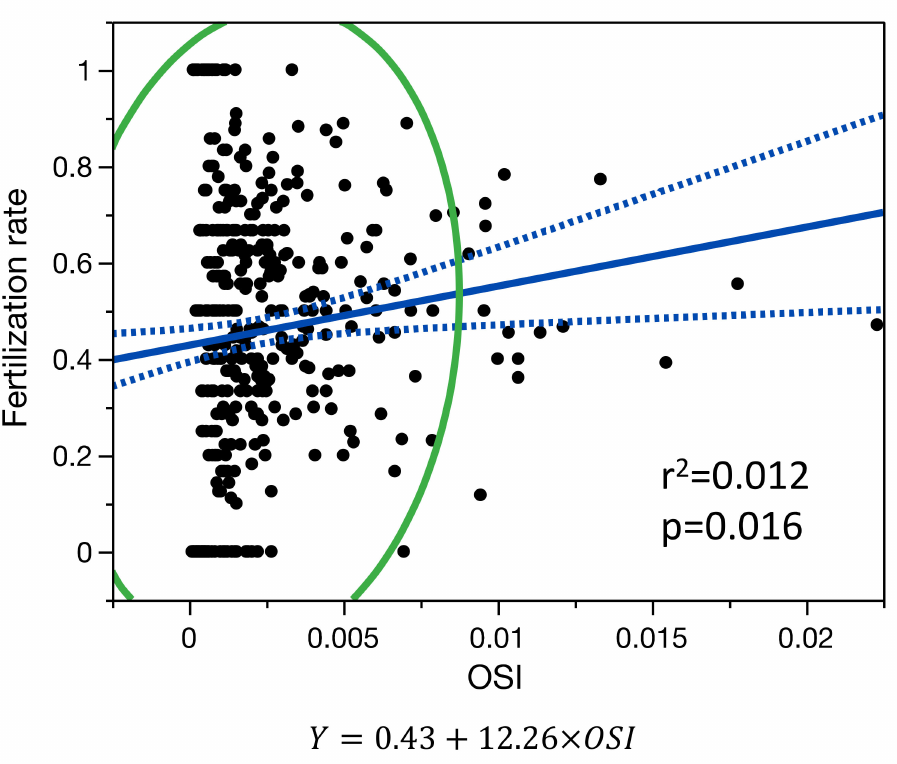
Figure 4. Single-variable linear regression model for the relationship between fertilization rate and OSI. Blue line is the fit line of the model with its confidence interval; green line is the 95% density